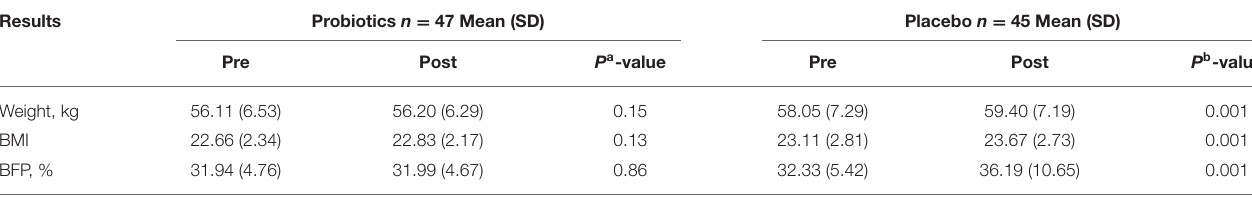
TABLE 3 | The changes of body weight, BMI, and BFP of participants enrolled over time. Results